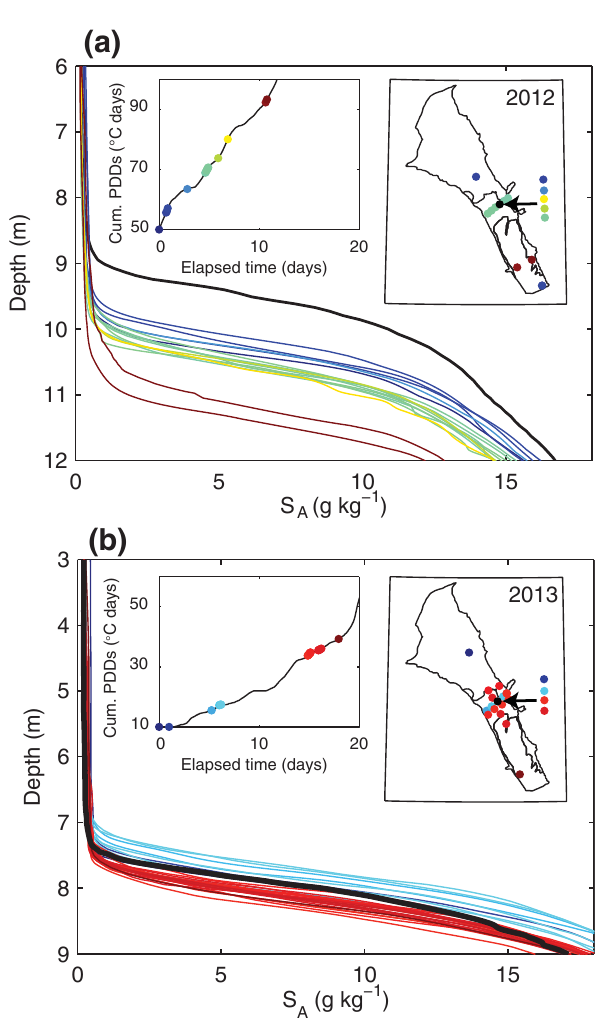
Figure 5. Salinity profiles showing seasonal changes in depth of the MEL halocline in (a) 2012 and (b) 2013. Profiles are coloured by time over the duration of each summer field campaign (10 days in June and July 2012 and 18 days in July 2013). A single profile col- lected in May of each year, prior to the onset of the melt season, is shown (black line). Note the different y axes range between (a) and (b) , although the increments are consistent. In (a) and (b) the left inset shows the PDDs (a proxy for the volume of surface melt- water inflow) accumulated during that field campaign, with the tim- ing of profiles indicated (coloured circles). The right inset shows the profiling locations on a map of Milne Fiord (the MEL, MIS, and Milne Glacier tongue are outlined). Multiple profiles were collected at the mooring site (black circle) during each